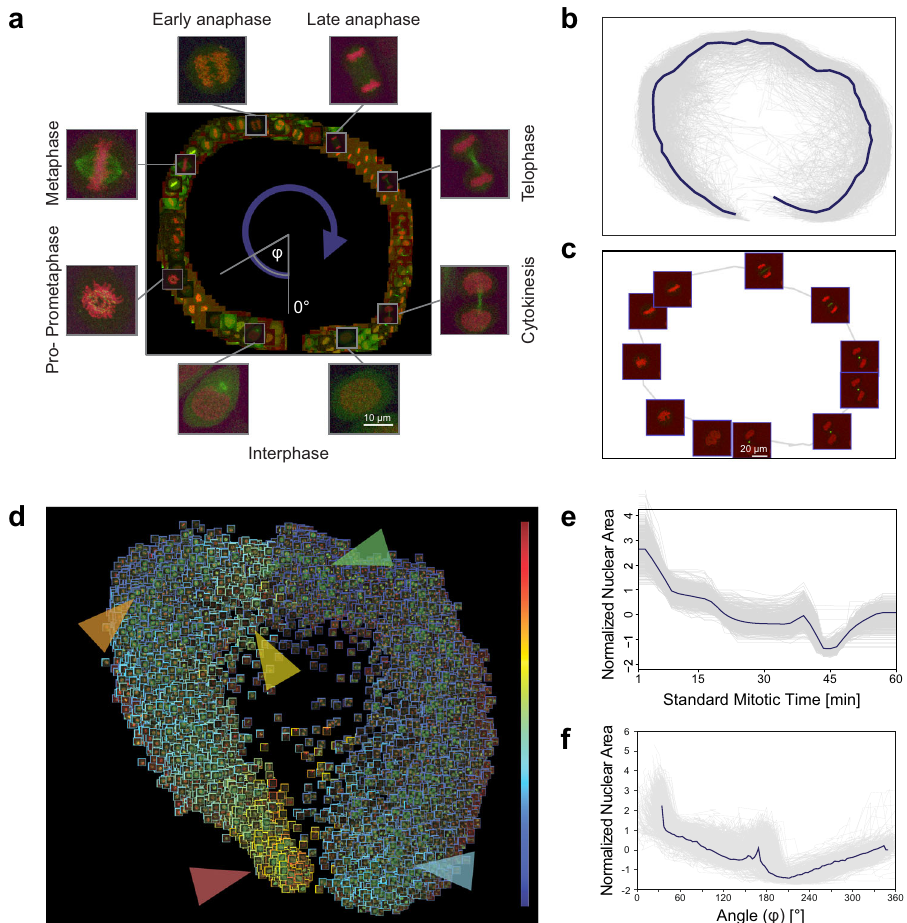
Fig. 3 Mitosis data analysis. a Regression plane of 585 cells annotated by a microscopy expert. b 498 trajectories for all the predicted cells. The median curve is shown in solid blue. c Example of a single-cell trajectory with representative cell icons visualized. d Regression plane with all ( n = 19,920) predicted cells. The borders of the cell icons correspond to their nuclear area (Colour Frame module). Highlighted regions: early prophase region, large nuclear area (red). Metaphase region, nuclear area decreased (orange). Early-anaphase region, nuclear area is increasing as spindle fi bres are pulling chromosomes apart (yellow). Anaphase, nuclear area dropped as the nucleus is considered as two separate objects with half the area (green). Late-telophase, nuclear area increasing up to half of the initial value (blue). e Trend for the normalized nuclear area according to standard mitotic time. Grey lines represent single- cell trajectories. f Trend for the normalized nuclear area according to the regression plane. Grey lines represent single-cell trajectories. The coordinates predicted by RP were converted to 1D by taking the angle argument of the polar coordinate representation as illustrated in a middle point, and assigned a colour to that, ranging from white (process 1) to blue (process 6). The colour of the cells in each process was then de fi ned by linear interpolation between the colour of the middle point and one of the two endpoints. The generated dataset was deposited to the Broad Bioimage Benchmark Collection (BBBC), and it is freely available at: https://data.broadinstitute.org/bbbc/ image_sets.html (dataset ID: BBBC031).